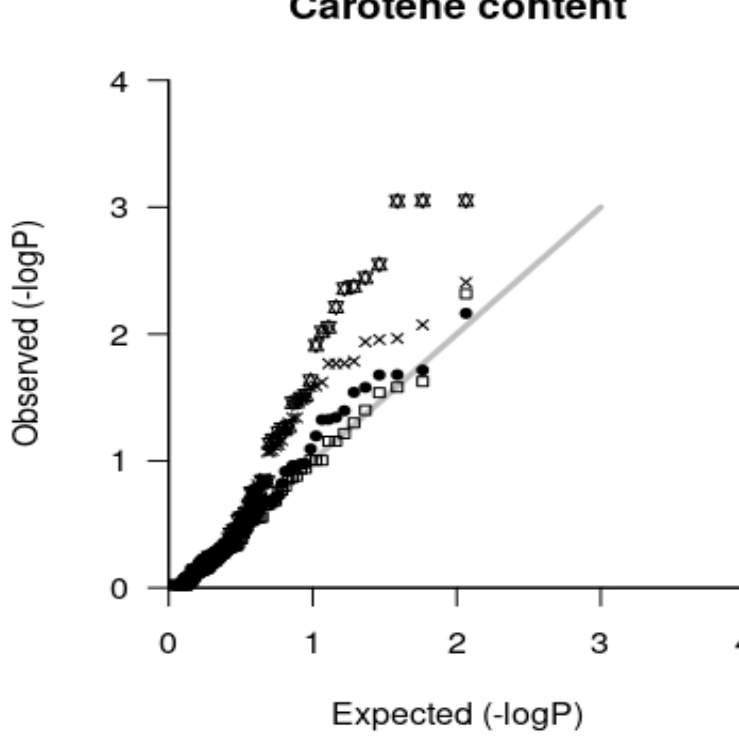
Figure 1. Example for a Quantile-Quantile (QQ) plot for Carotene contents (Car). Candidate gene (CG) data points of alternative generalized linear model (GLM) with structure matrix (Q) or principle component analysis matrix (PCA) as covariates: GLM_Q, GLM_PCA, respectively, and mixed linear models (MLM) incorporating in addition the IBS Kinship matrix (K) into the models: MLM_Q+K, MLM_PCA+K. They are represented by different symbols. (black circles: MLM_PCA+K; white squares: MLM_Q+K; stars: GLM_Q; crosses: GLM_PCA). Table 3. Average square distance (d 2 ) values of the CG data points from the diagonal of the QQ plot for determining the best fitting model for each trait.